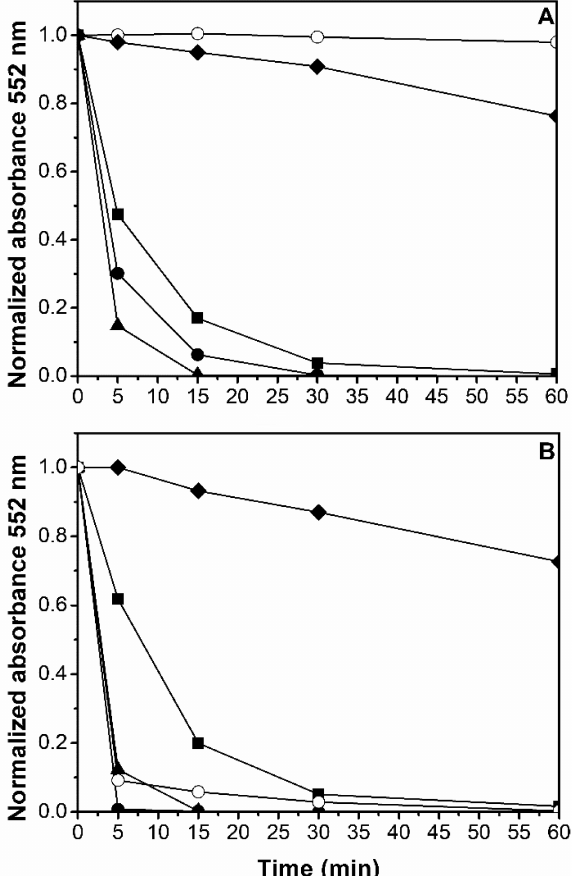
Figure 4. Dye decolorization (RB 5 mg/L) profiles with the different studied Advanced Oxidation Processes (AOPs) with air flow of 30 L/min at ( A ) natural pH and ( B ) pH 2.8. Studied processes are represented as follows: UVC